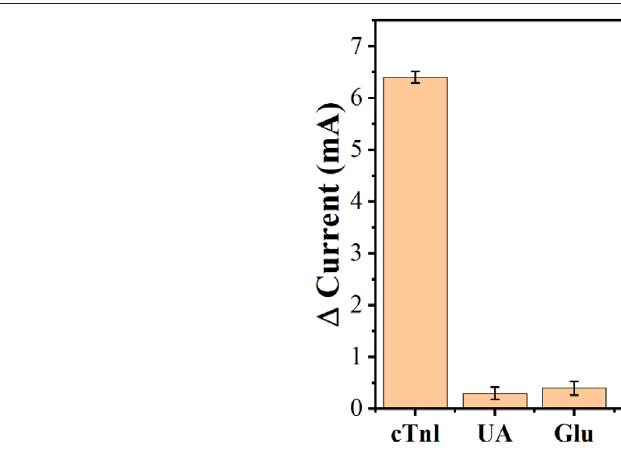
FIGURE 8 | Anti-interference performance of the AcTnI/AgNPs/MoS 2 /rGO/GCE toward UA, Glu, MB, DP, and